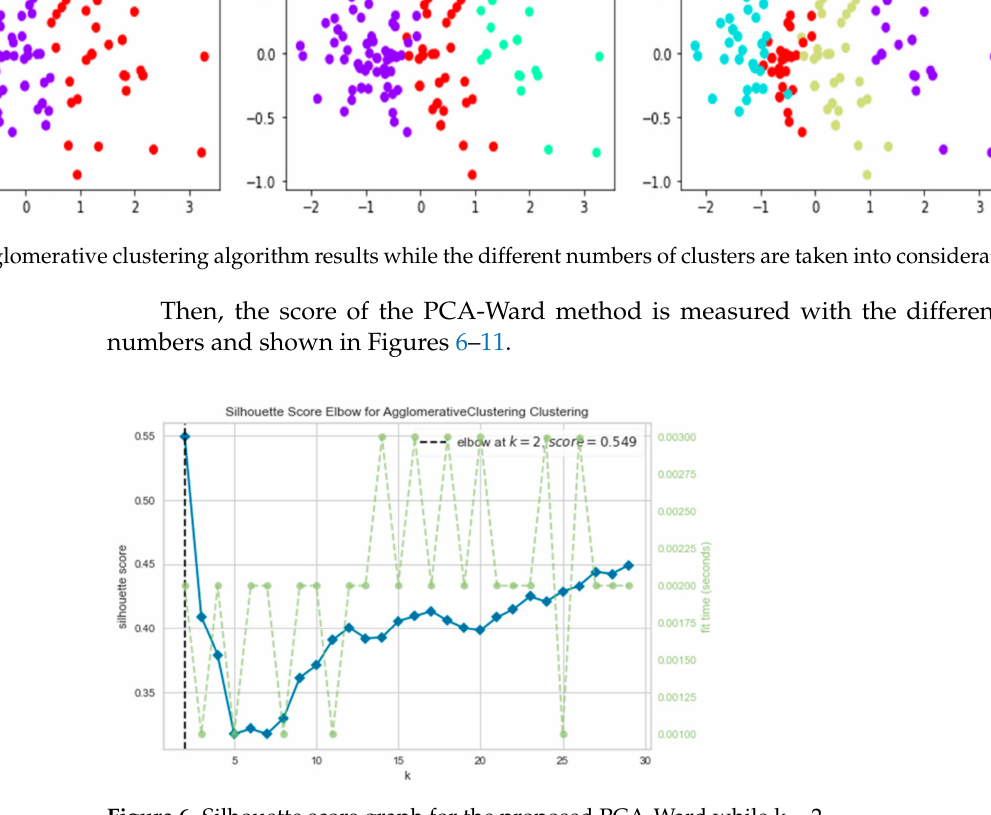
Figure 6. Silhouette score graph for the proposed PCA-Ward while k = 2.